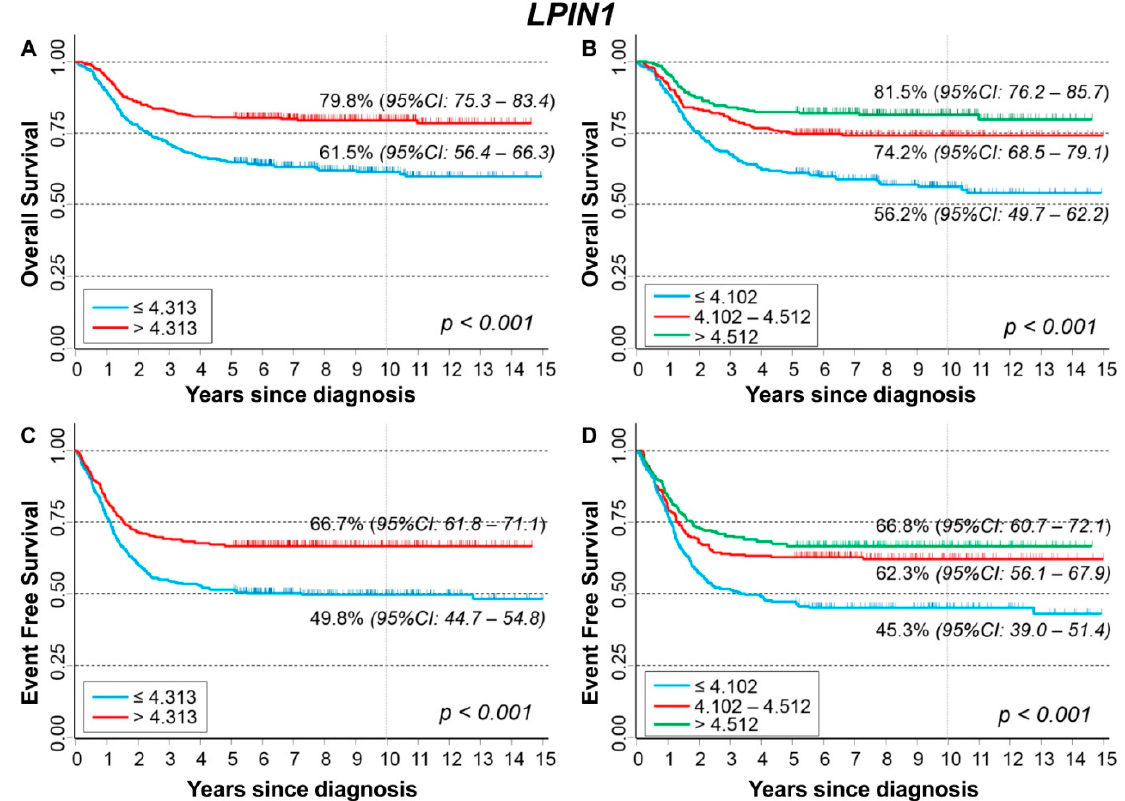
N/E = Number of patients/Events HR: Hazard Ratio. Multivariable analysis: HRs are adjusted by MYCN status, age, and stage at diagnosis. Figure 20. Patient Survival in relation to LPIN1 expression level. Overall Survival of 786 NB patients with ( A ) cut-off based on the median expression value or ( B ) on tertile expression values. Event Free Survival of 769 NB patients with ( C ) cut-off based on the median expression value or ( D ) on tertile expression values. Ten-year survival estimates are displayed.